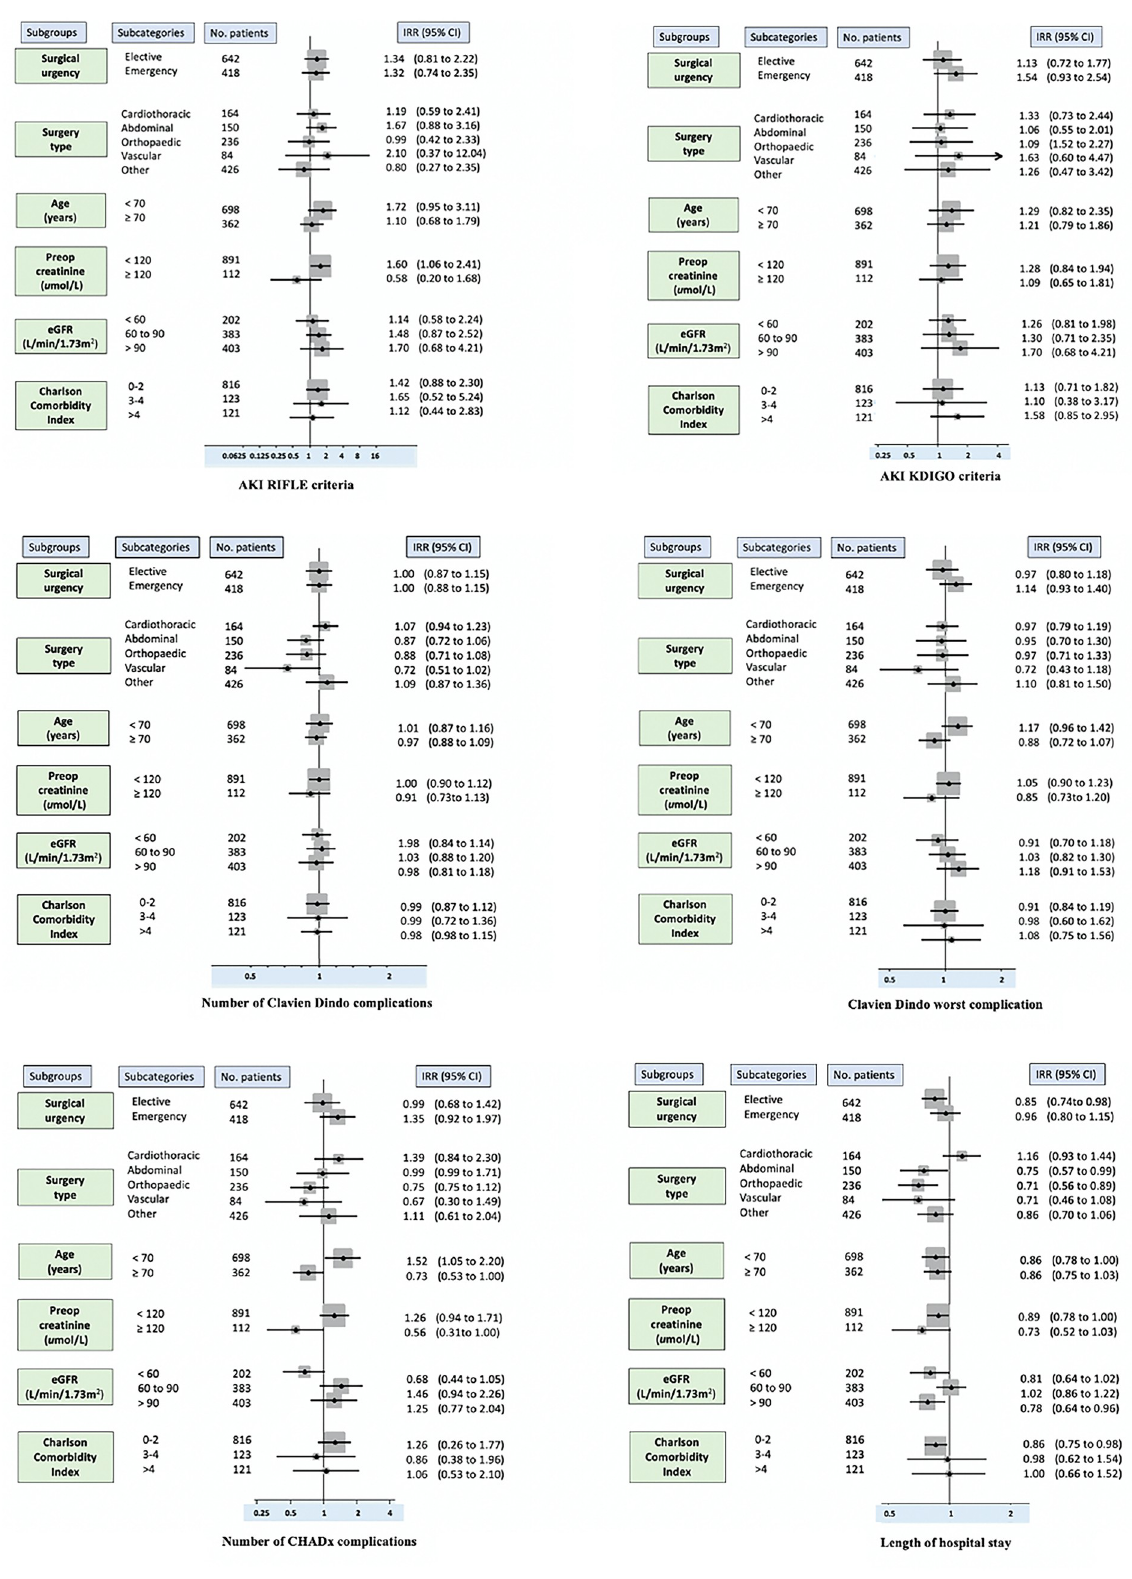
Fig 4. Incidence rate ratios of key outcomes for patients receiving Plasma-Lyte compared to Saline.